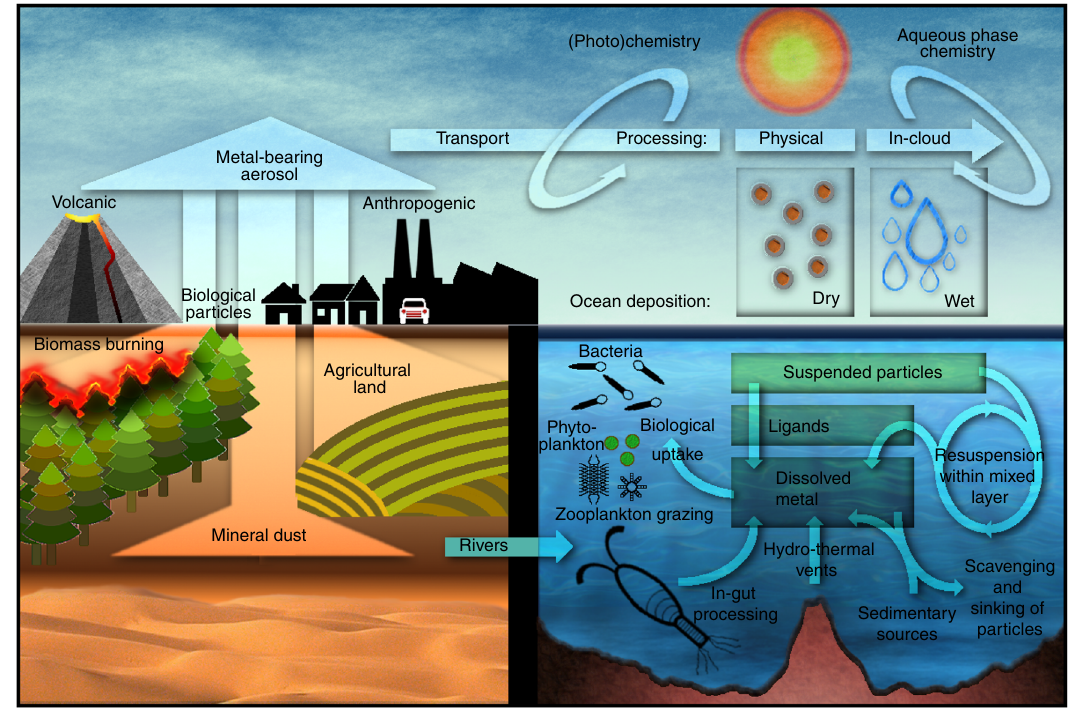
Fig. 2 Schematic of aerosol metal dissolution and impacts on the ocean. Metal-bearing aerosols are emitted from natural (mineral dust, volcanoes, biological particles, and biomass burning) and anthropogenic activities (industrial combustion, agriculture, and land conversion), mostly over land. Combustion sources tend to have more soluble metals than the larger mineral dust sources. Some of the aerosols are transported to ocean regions, and can become processed so that the metals are more soluble by acids, photochemical and/or cloud processes, before being deposited to the oceans. In the oceans, the metals in the particles experience different chemical conditions, and can become more or less soluble, due to changes in acidity and ligands, for example. The metals can be cycled through bacteria, phytoplankton and zooplankton, and/or sink through the ocean to be scavenged in the deep ocean, or be deposited into the sediment. Sedimentary sources, riverine inputs, and hydrothermal vents can be important for many metals, as sources of new metals in the